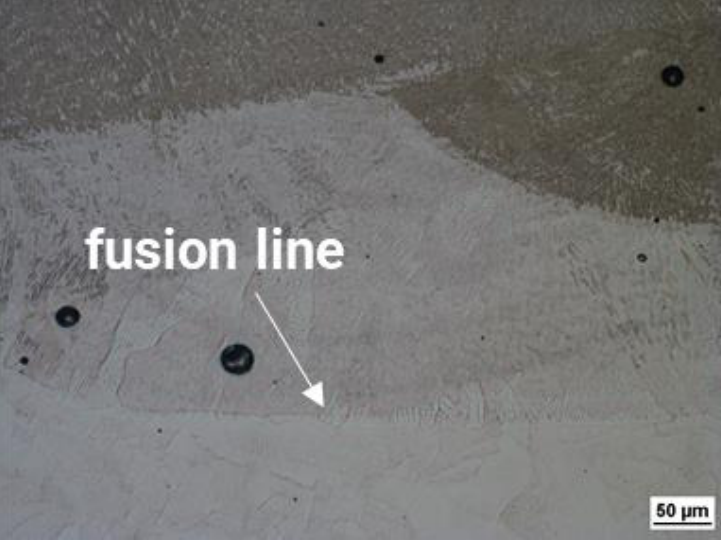
Figure 12. 1_T specimen microstructure showing the incomplete martensitic transformation .